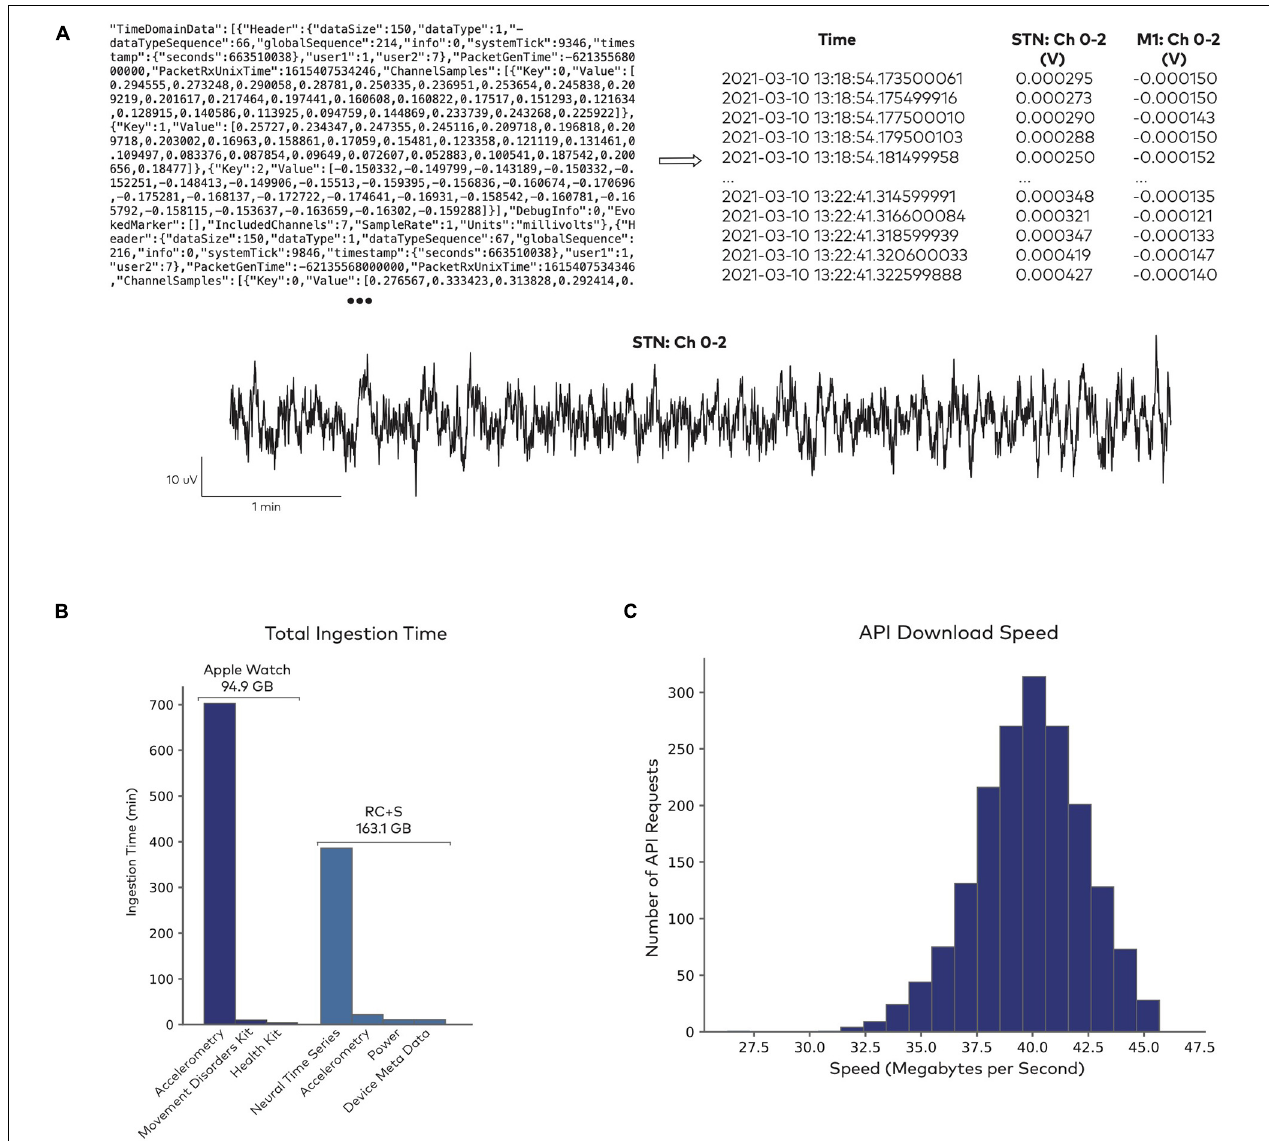
FIGURE 2 | Data access through Rune’s API. (A) Sample of raw data from the Summit RC + S system (top left), which gets parsed into a human-readable format and indexed for storage (top right). Both the raw and parsed data formats are accessible for further analysis (bottom). (B) Data ingestion performance in sample datasets. Total time for ingesting 10661 Apple Watch datasets, totalling 94.9 GB, and 1983 RC + S datasets, totalling 163.1 GB. Raw data formats are parsed into separate fields, such as accelerometry time series, derived health metrics from the Apple Watch (heart rate, step count, etc.), neural time series, and device meta data. (C) Data access through Rune’s API. Distribution of data download speed across 1,800 randomized API